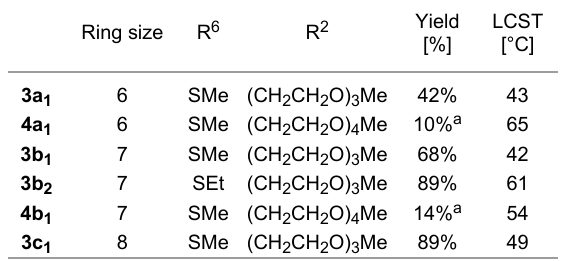
Table 1: List of the synthesized CD derivatives and their lower critical solution temperatures